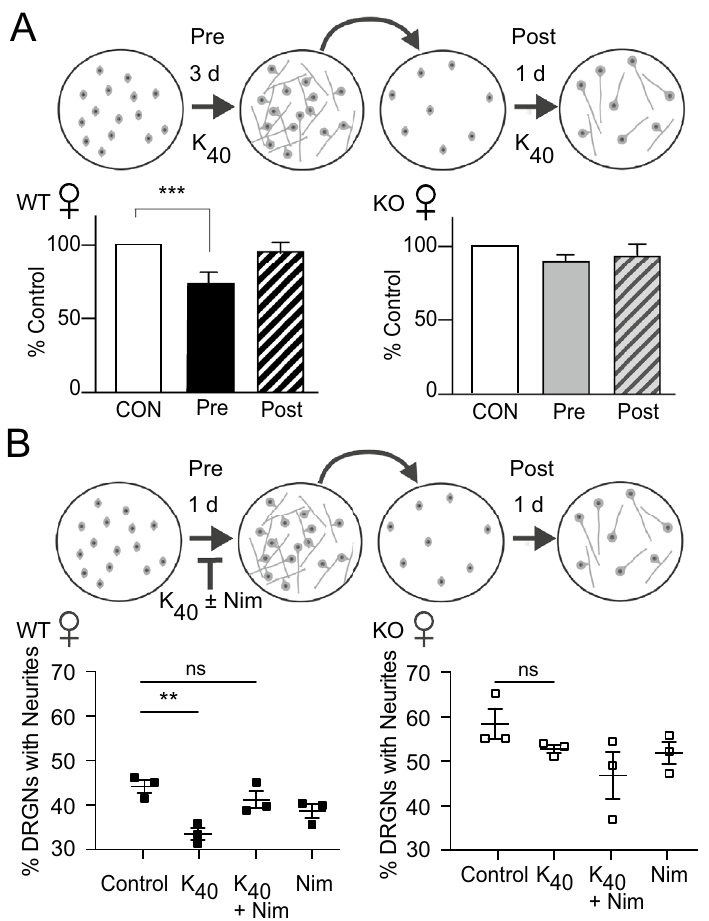
Figure 7. Caldendrin mediates coupling of Ca v 1 channels to the transcription-dependent phase of neurite growth. ( A ) Top panel, schematic of the experimental design indicating exposure of cultures to K 40 either before or after replating. Bottom panel, longest neurite per DRGN was measured in control and experimental groups. *** p = 0.0002, F(2,6) = 49.96 by one-way ANOVA, Holm-Sidak’s multiple comparisons test. ( B ) Same as in A except that DRGNs were exposed to K 40 ± nimodipine (Nim, 10 µM) before (1d) or after replating. % DRGNs with neurites was determined as in Fig. 5. Each data point represents the average determined from ~ 400 DRGNs per culture. ** p = 0.004, F(3,8) = 8.3 determined by one-way ANOVA with Dunnett’s multiple comparisons